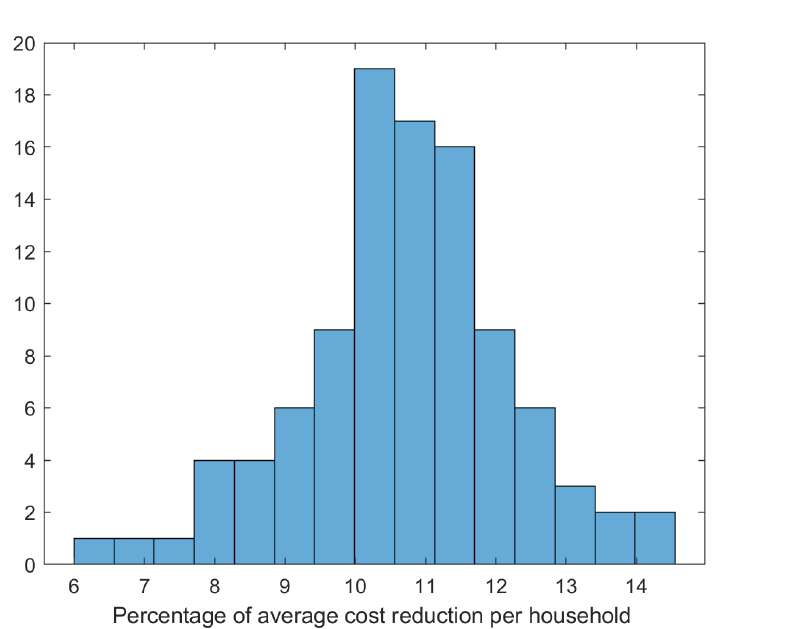
Figure 6. Histogram of the average cost reduction per household (in percentage) when using the Reinforcement learning approach based on Equation